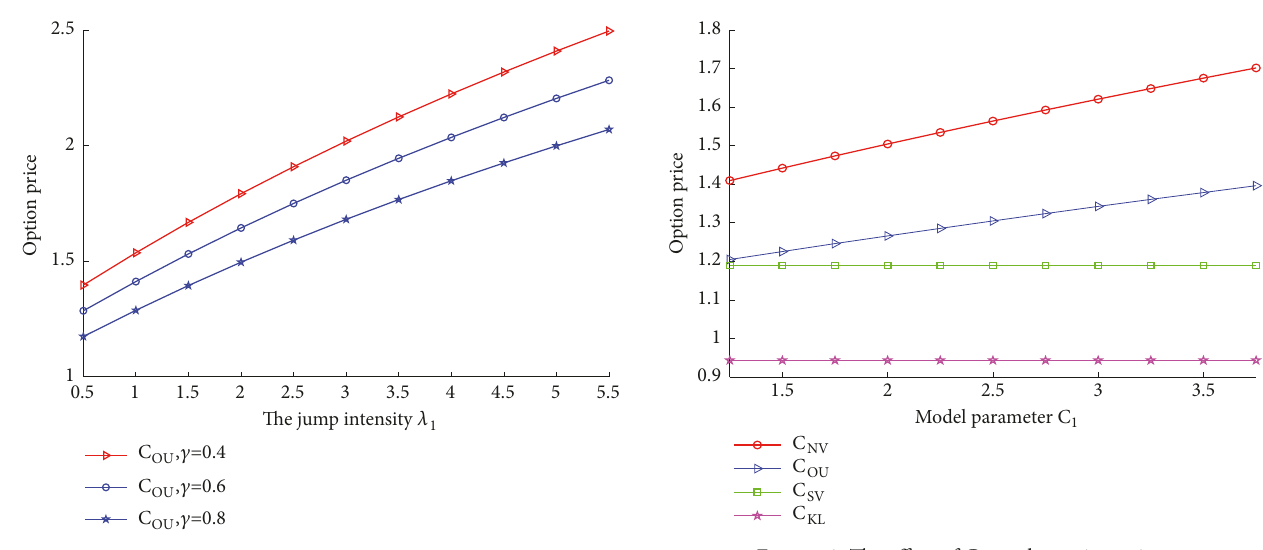
Figure 6: The effect of the jump intensity 𝜆 1 on the vulnerable option prices.